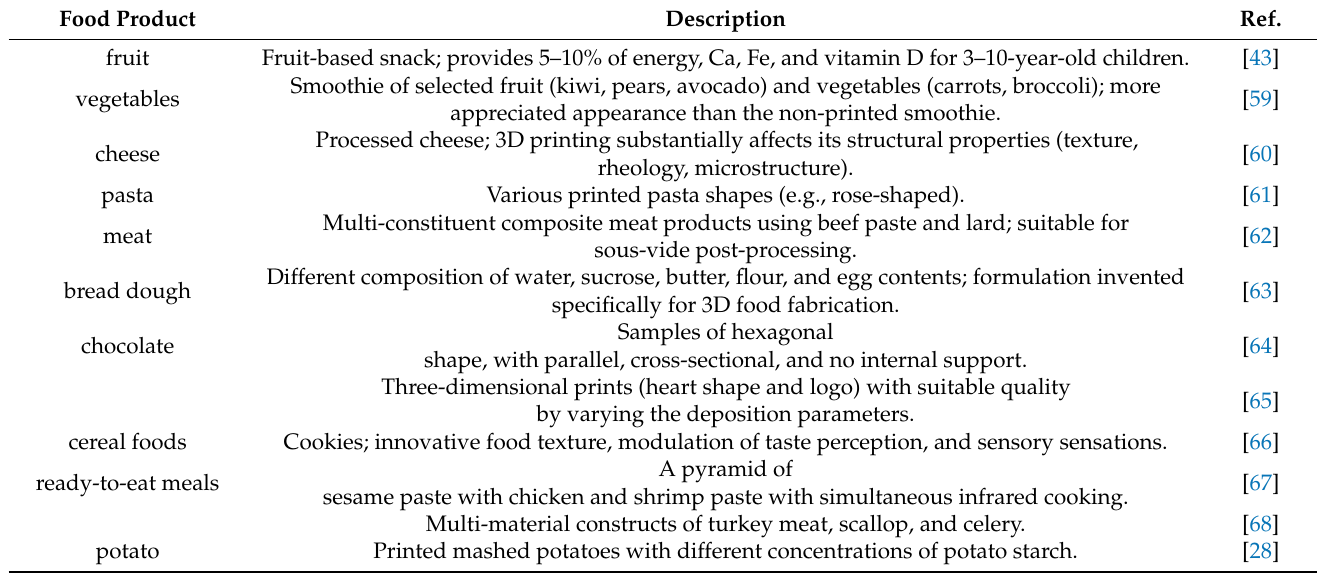
Table 1. Types of food products obtained with 3D